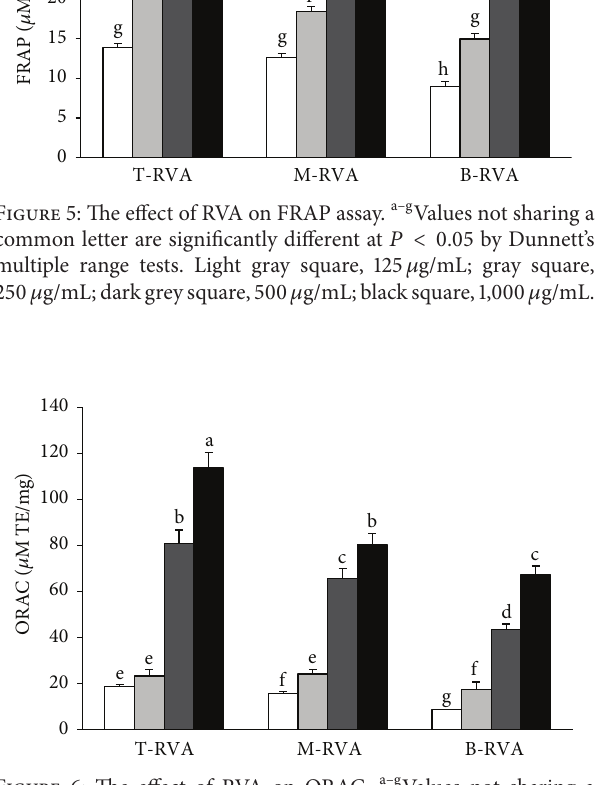
Figure 6: The effect of RVA on ORAC. a – g Values not sharing a common letter are significantly different at 𝑃 < 0.05 by Dunnett’s multiple range tests. Light gray square, 125 𝜇 g/mL; gray square, 250 𝜇 g/mL;darkgreysquare,500 𝜇 g/mL;blacksquare,1,000 𝜇